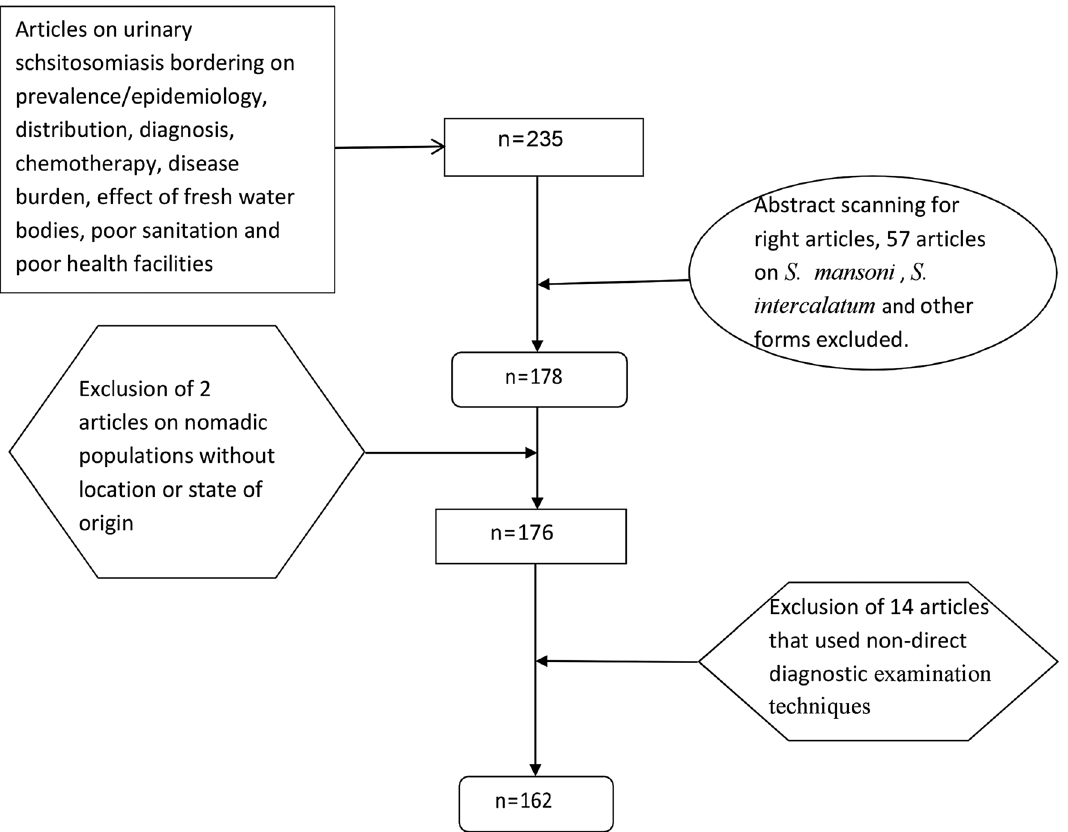
Figure 1. Article selection fl ow